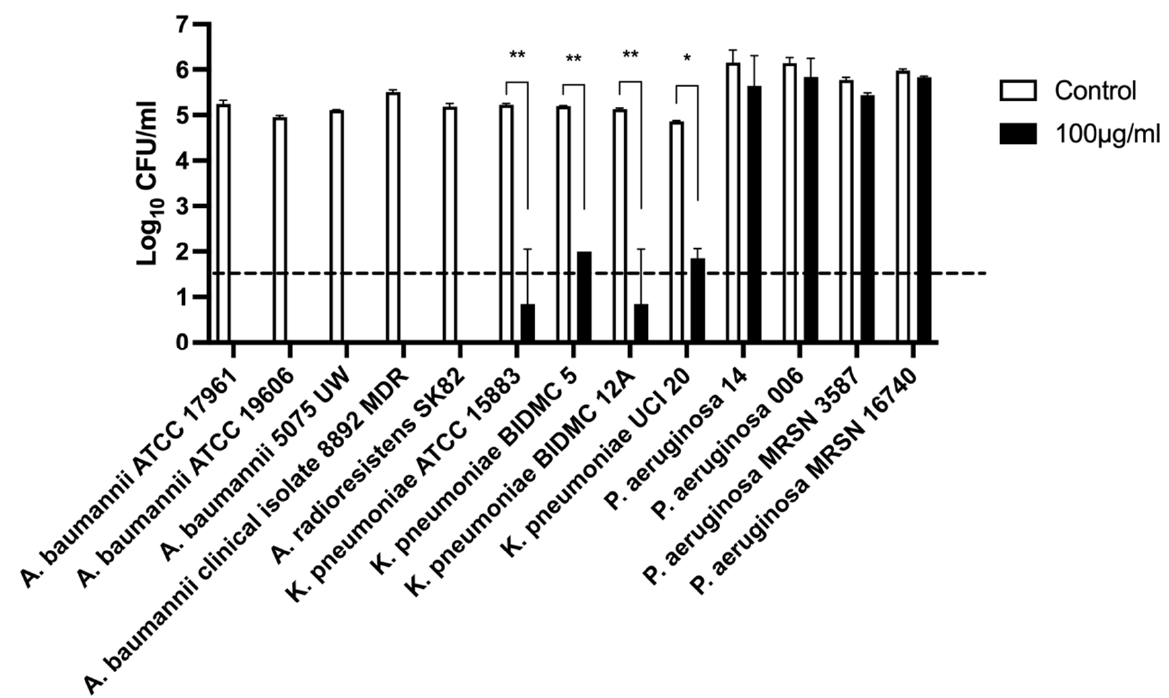
Figure 3. Lytic spectra of Abp013. A total of 4 A. baumanniii, 1 A. radioresistens , 4 P. aeruginosa , and 4 K. pneumoniae strains were incubated with 100 μ g/mL of Abp013 in 20 mM sodium phosphate buffer, pH 6.0, for an hour at 37 °C. The number of residual log10 CFU/mL was determined through plating 10-fold serial dilution in a bactericidal assay and compared with buffer-treated negative controls. Statistical significance was determined by a two-tailed Student’s t -test with Welch’s correction. * p < 0.05; ** p < 0.01. The dashed line indicates the limit of detection. The experiments were carried out in duplicates; error bars represent the standard deviation.